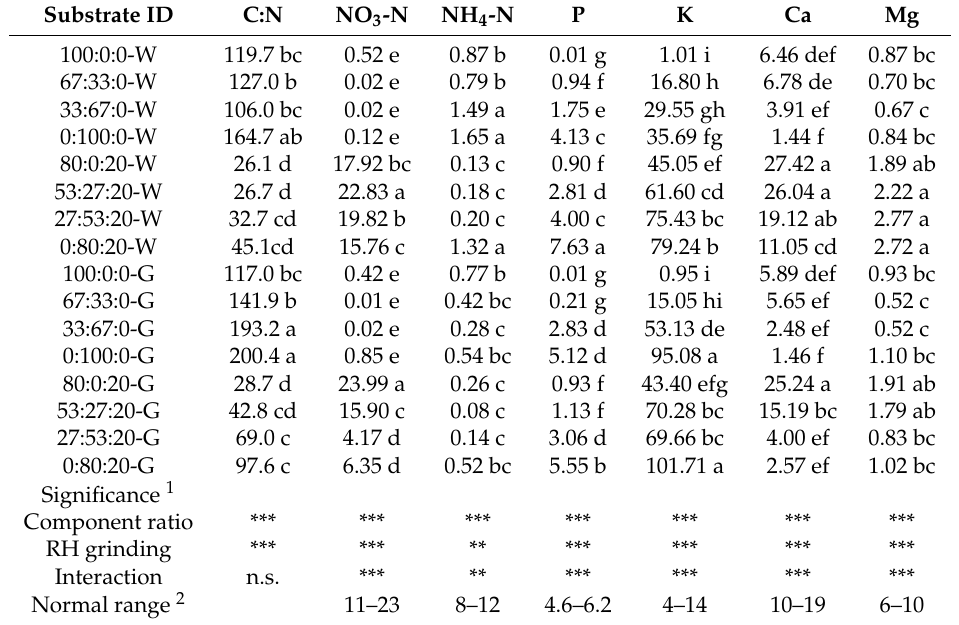
Table 3. Interaction e ff ect of component ratio and rice hulls (RH) grinding on the C / N ratio and concentration of macro- and meso-nutrients in the evaluated